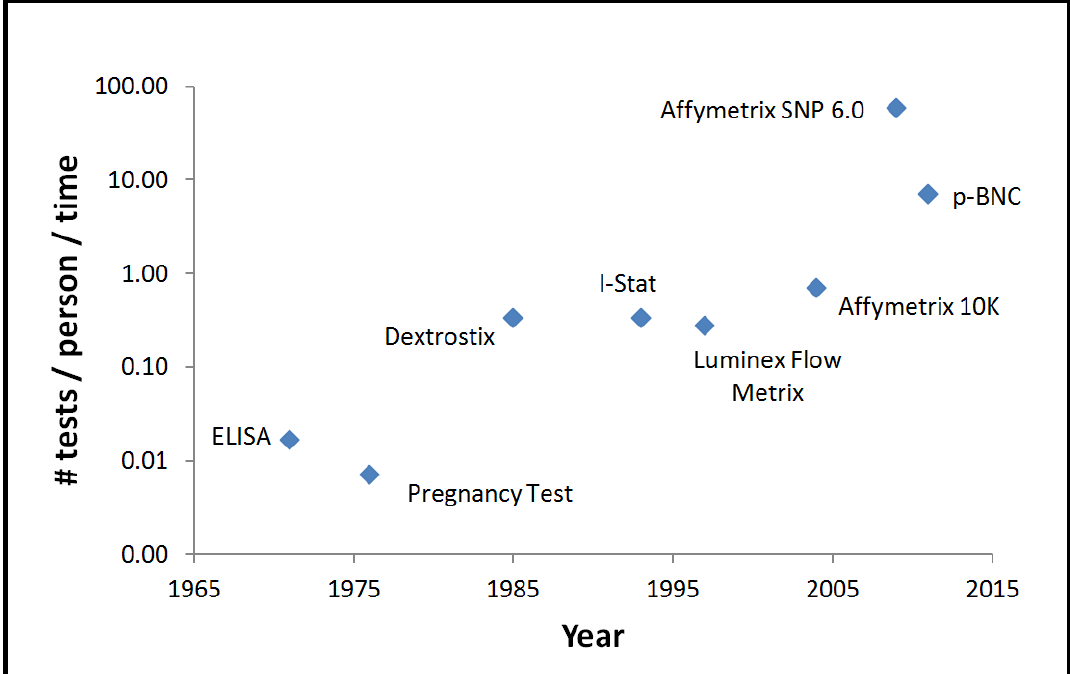
Figure 10. Graph over time showing the increase in Q, the number of tests performed per person per time, for various representative diagnostic